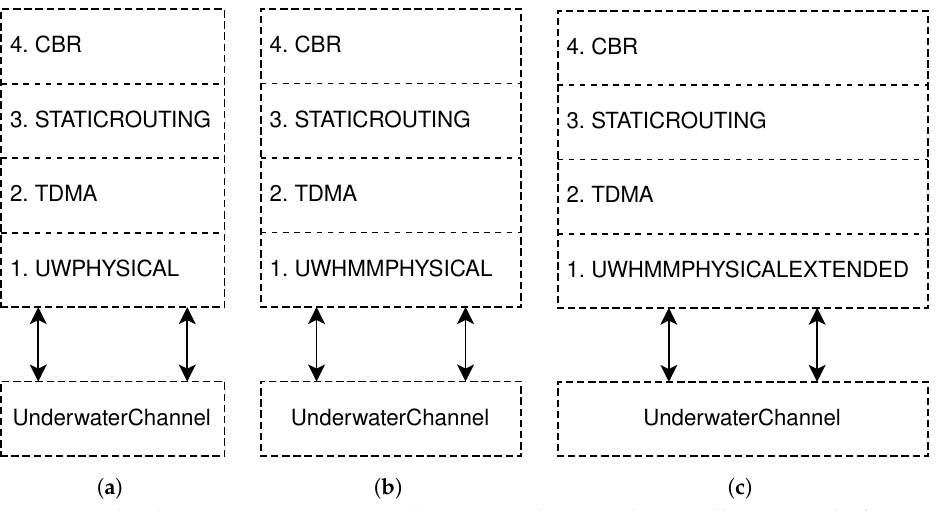
Figure 8. The three communication stacks compared in simulation, all composed of a constant bitrate application layer, static routing, and TDMA, and a different physical layer: Uwphysical ( a ), UWHMMPhysical ( b ), and UWHMMPhysicalExt ( c ).